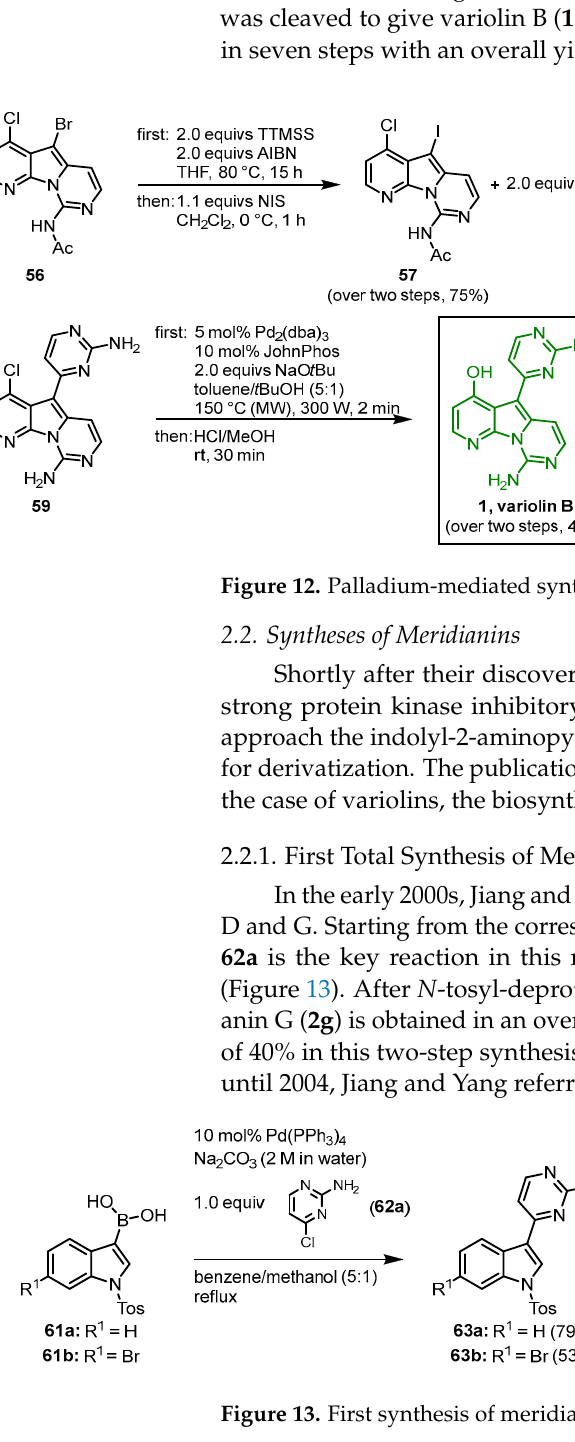
Figure 11. Synthesis of the trihalo core and introduction of the C-9 amino substituent [51].